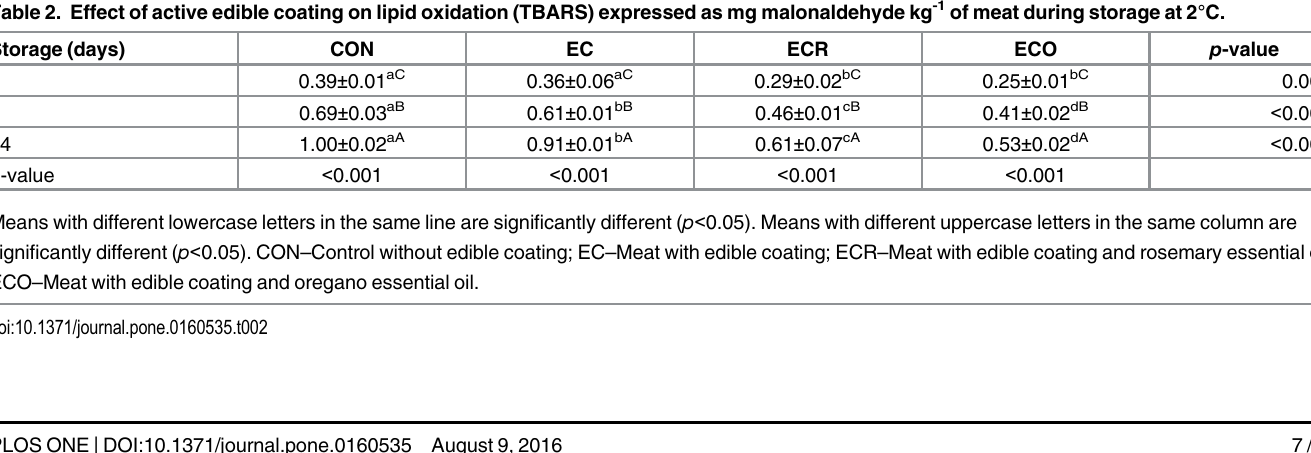
Table 2. Effect of active edible coating on lipid oxidation (TBARS) expressed as mg malonaldehyde kg -1 of meat during storage at 2°C. Storage (days)